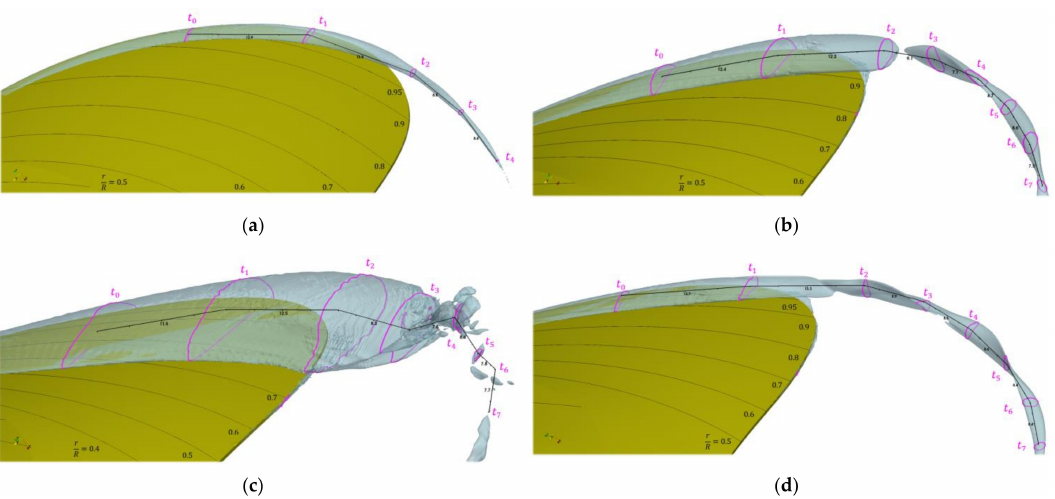
Figure 12. Newcastle. Tip vortex cavitation isosurface with stations and normalized arc length approximation along helix: ( a ) C1; ( b ) C2; ( c ) C3; ( d )